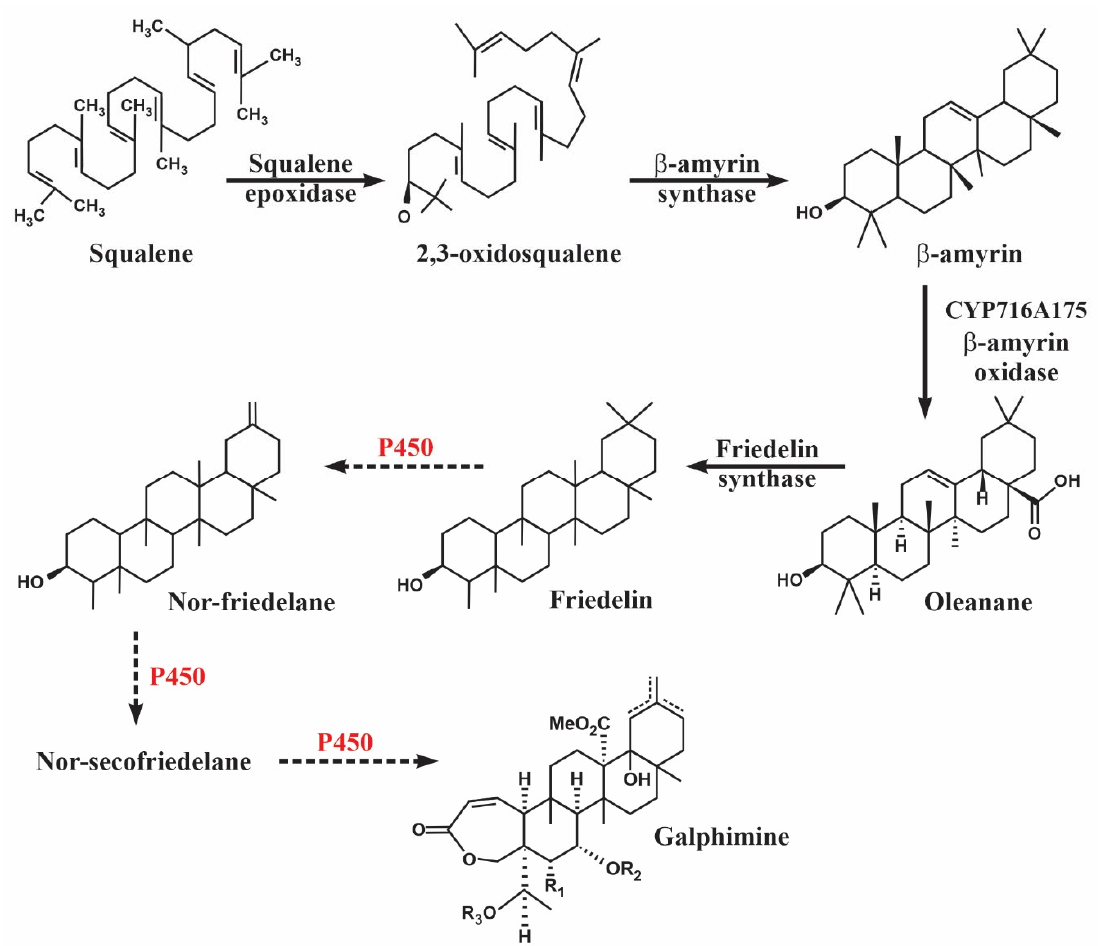
Figure 9. Proposed galphimines synthesis pathway mediated by cytochrome P450 in Galphimia spp. plants. Solid arrows indicate pathway reactions identified in previous work [18,28]. Dotted arrows indicate reactions proposed in this study.